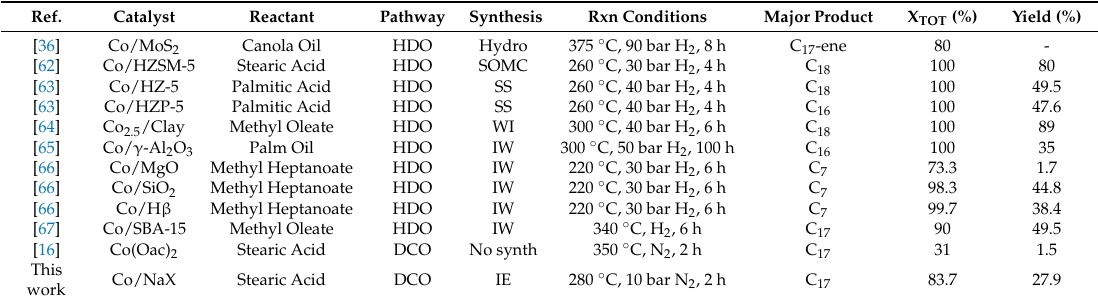
Table 4. State-of-the-art comparison of Co-based catalysts in the deoxygenation of vegetable oils.